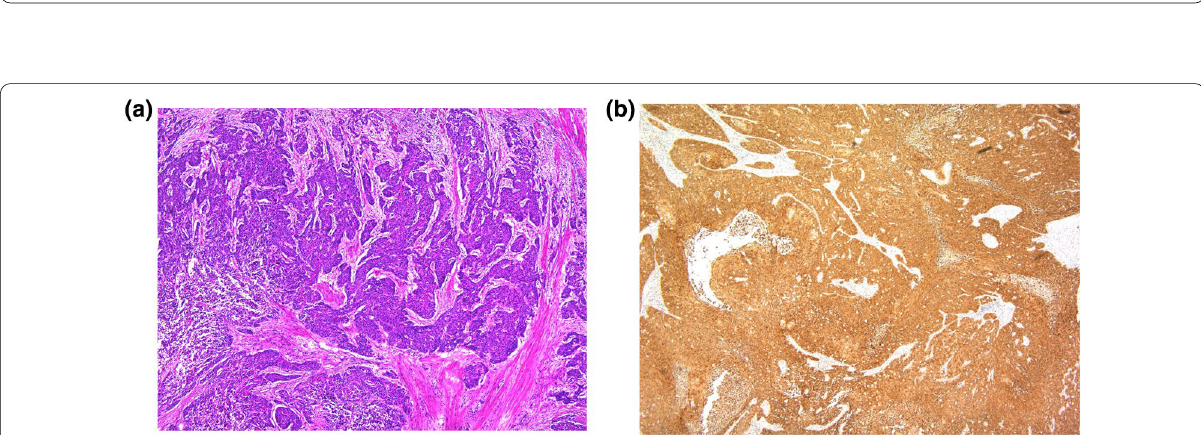
Fig. 2 a , b Preoperative CT scan and MRI of the abdomen showing multiple liver metastases (white arrows). CT computed tomography, MRI magnetic resonance